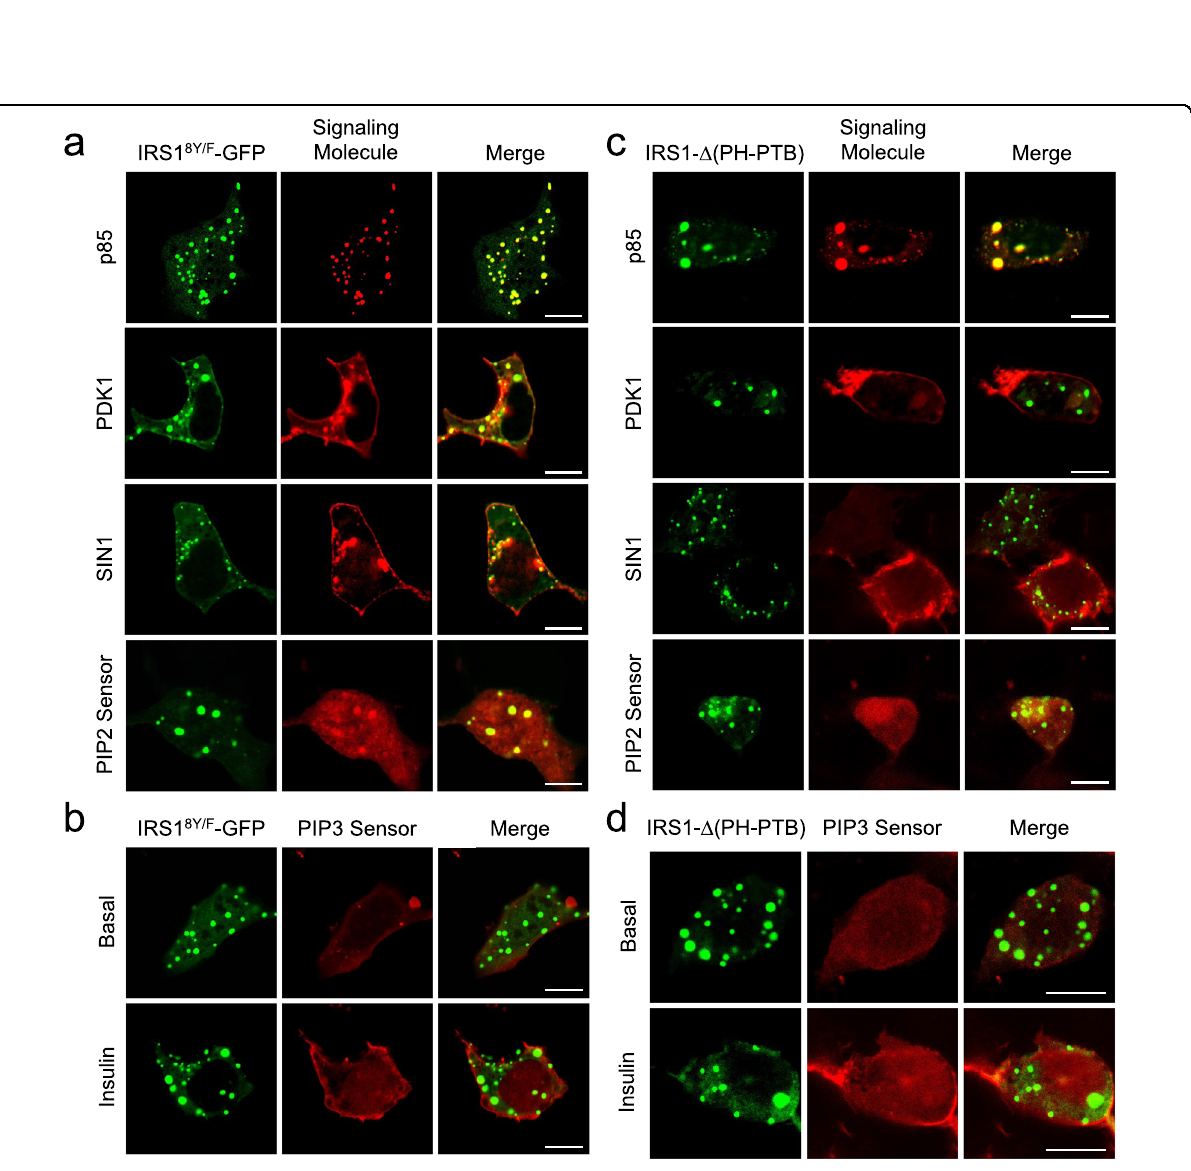
Fig. 7 Recruitment of signaling molecules and PIP3 production in mutant IRS1 condensates. a Cellular localization of IRS1 8Y/F -GFP co- expressed with mCherry-p85, mCherry-PDK1, mCherry-SIN1 and PIP2 sensor in HEK293T cells. Scale bar, 10 μ m. b Cellular localization of IRS1 8Y/F -GFP co-expressed with PIP3 sensor in response to insulin stimulation in HEK293T cells. Scale bar, 10 μ m. c Cellular localization of IRS1 Δ (PH-PTB)-GFP co- expressed with mCherry-p85, mCherry-PDK1, mCherry-SIN1, and PIP2 sensor in HEK293T cells. Scale bar, 10 μ m. d Cellular localization of IRS1 Δ (PH- PTB)-GFP co-expressed with PIP3 sensor in response to insulin stimulation in HEK293T cells. Scale bar, 10 μ